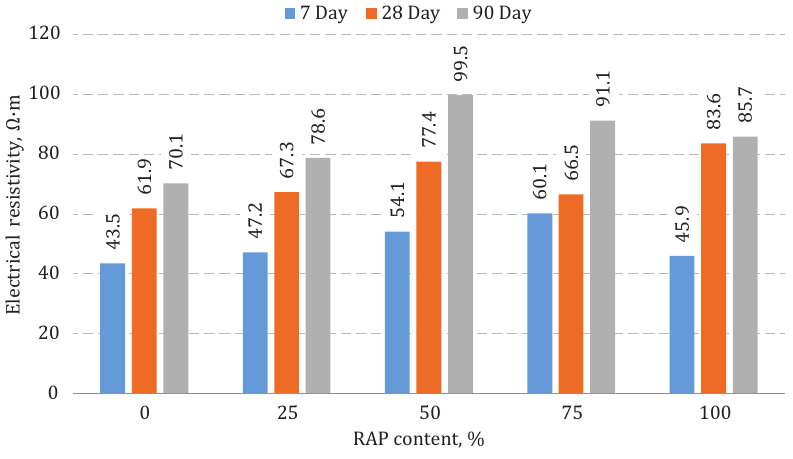
Figure 18. Electrical resistivity of the mixtures containing different amounts of